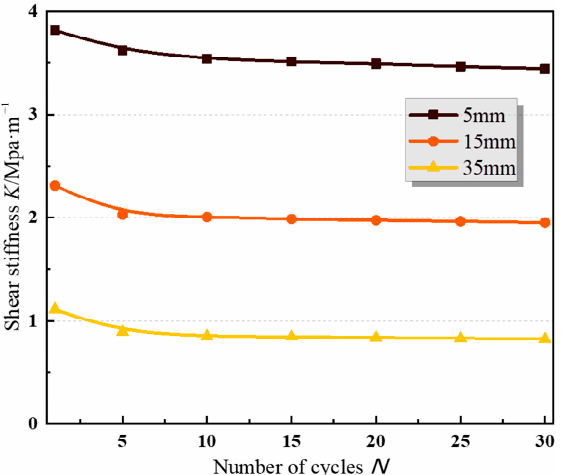
Figure 19. Shear stiffness–cycle number curve under different shear amplitude levels.